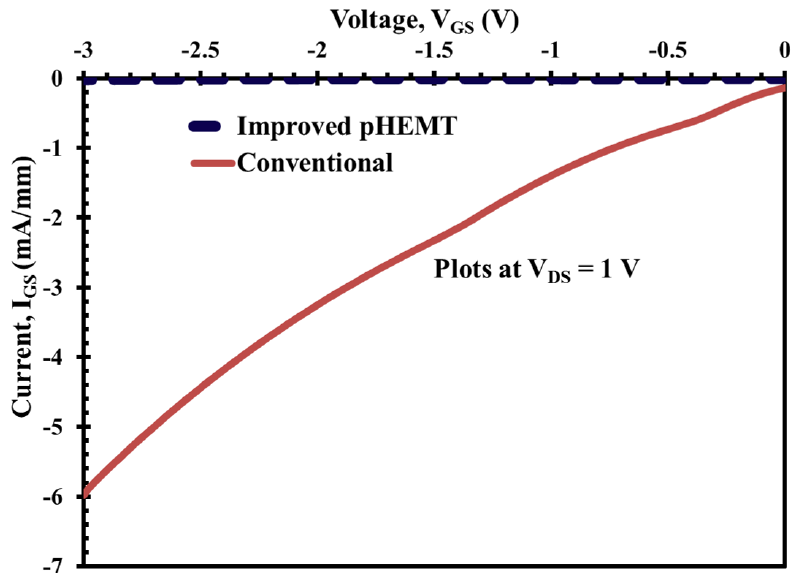
Figure 11. XMBE171 (conventional pHEMT) and XMBE56 (improved pHEMT) on-state Schottky gate leakage current at V GS = − 3 V, in